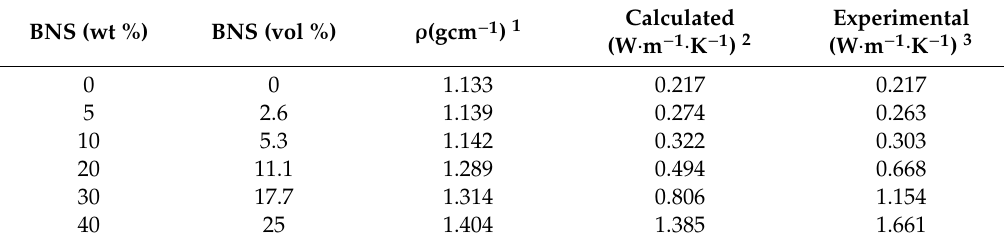
Table 1. The volume fraction of filler and the density and thermal conductivities of the